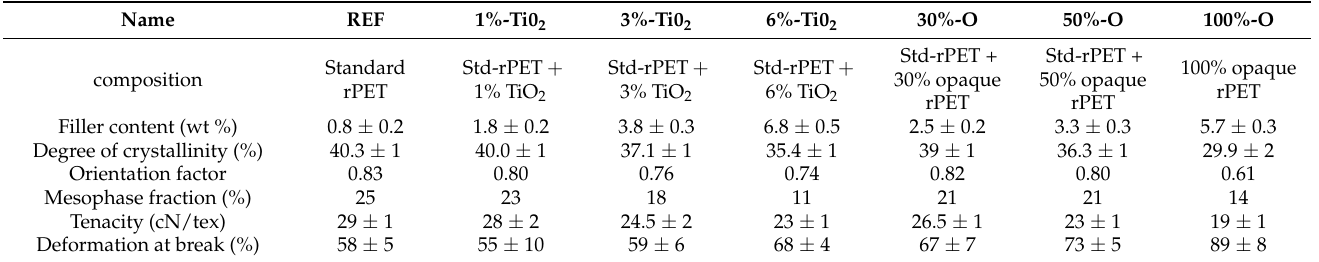
Table 4. Main properties of the two sets of melt-spun filaments and the reference.